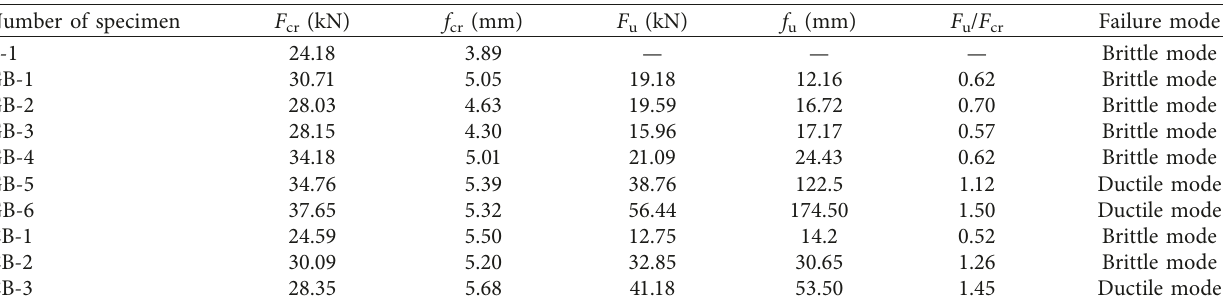
Figure 33: Cracking location (mm). Table 8: Test result of NSM screw-thread steels and CFRP bars.